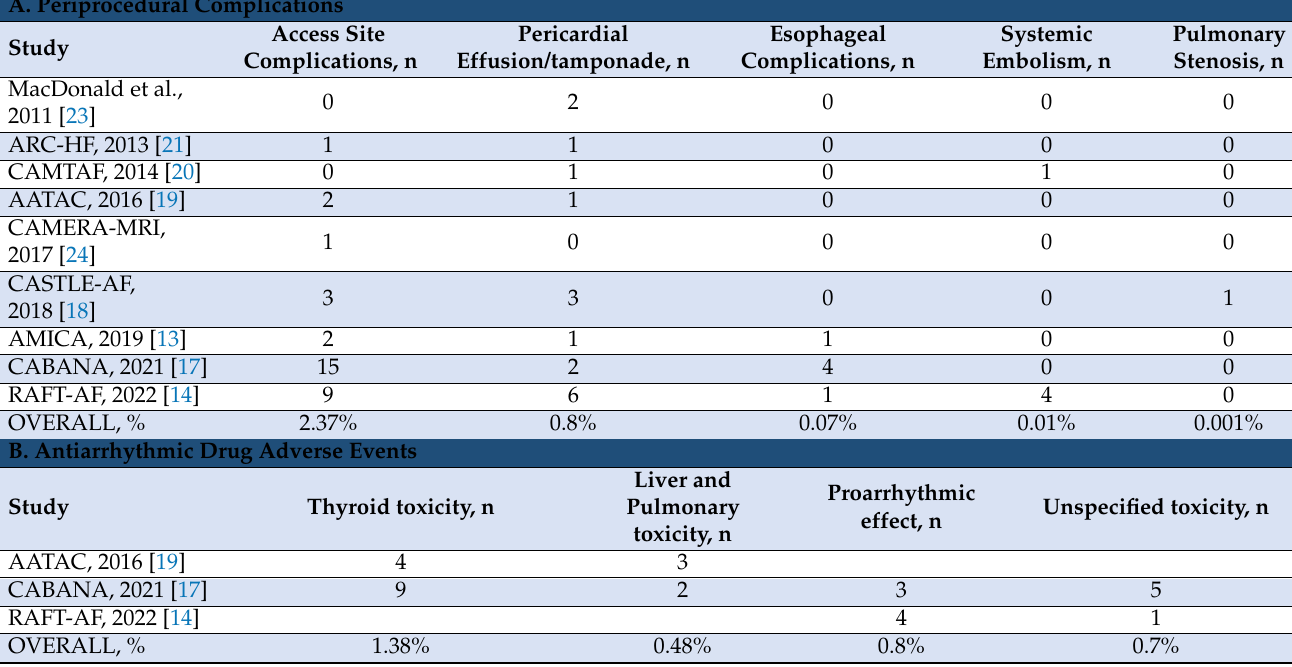
Table 2. Periprocedural Complications of Catheter Ablation (A) and Adverse Events of Antiarrhyth- mic Drugs